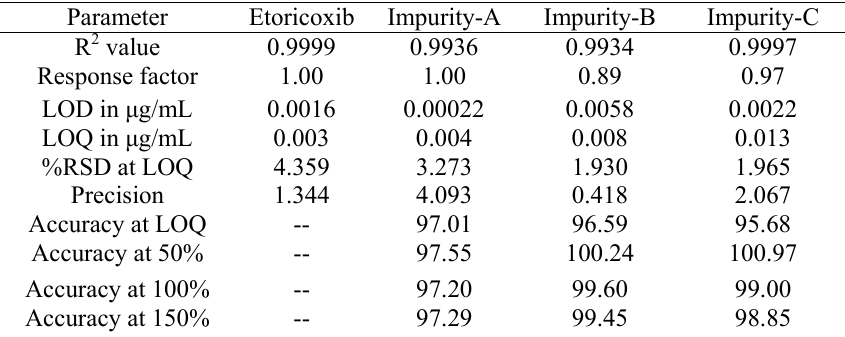
Table 3. Validation results